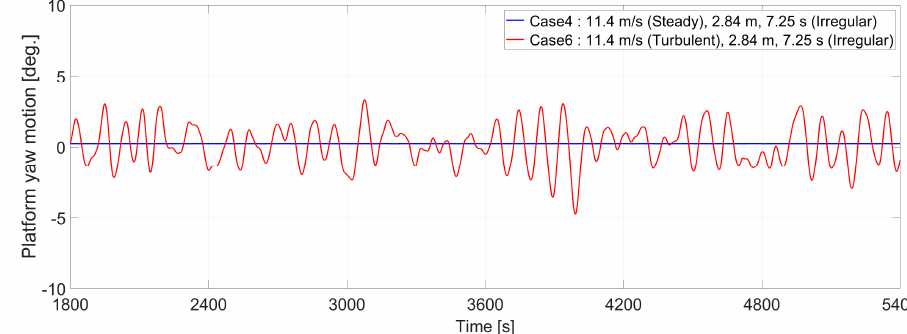
Figure 8. Time series of the platform’s yaw motion for cases 4 and 6.